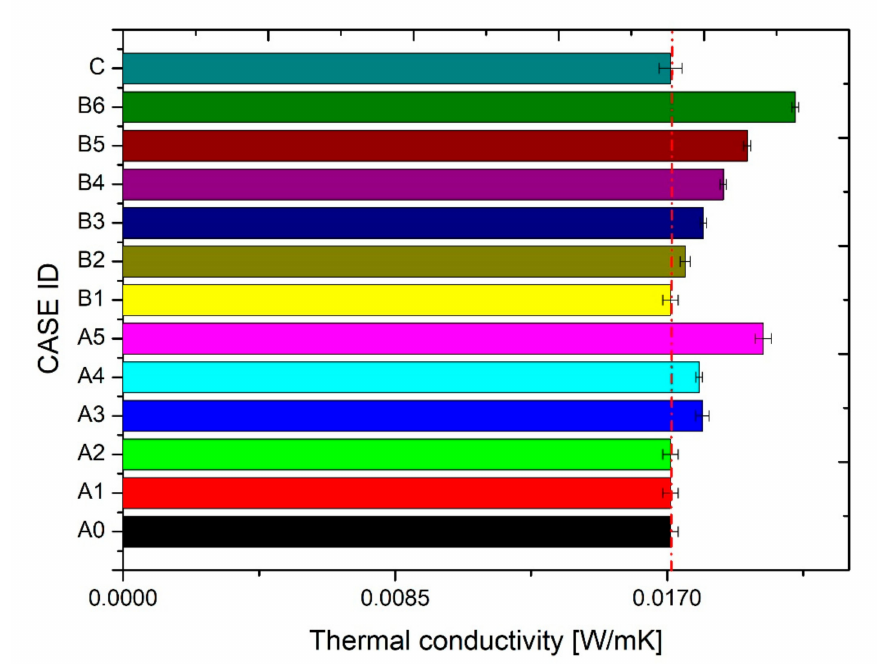
Figure 3. The measured thermal